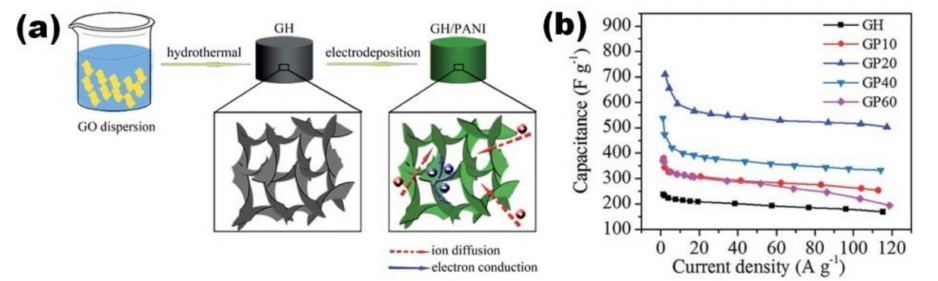
Figure 15. Schematic illustrating the fabrication process toward GH/PANI (GP) composite and 3D ion and electron transport pathway in porous GH/PANI electrode ( a ). Plots of specific capacitance versus discharging current density for GH/PANI composites prepared for different times of PANI electropolymerization (10, 20, 40 and 60 s, respectively) compared with GH electrode ( b ) (Reprinted from [56] with permission of RSC Publishing).